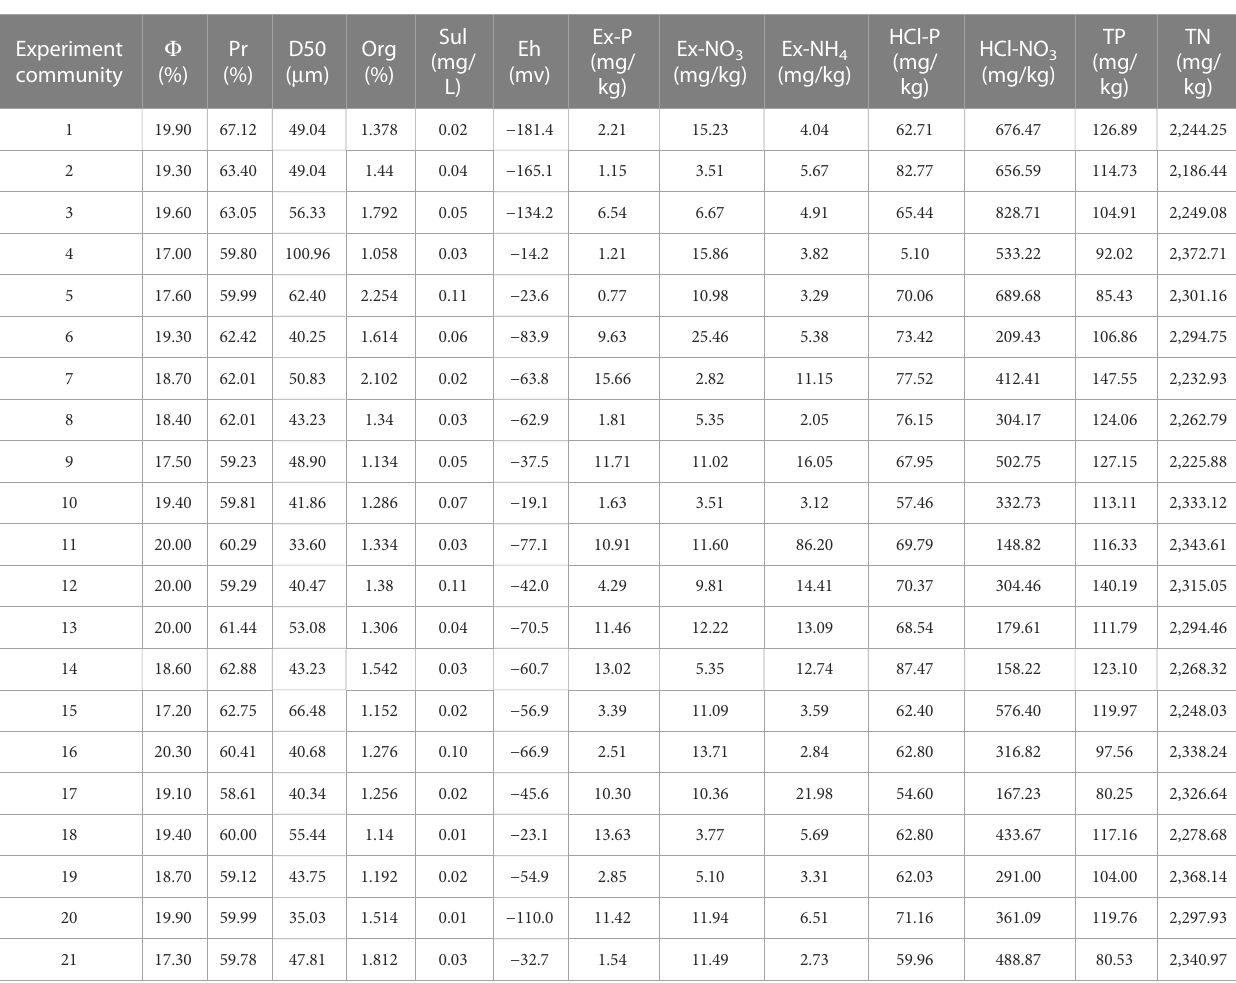
TABLE 2 Sediment factors ( j , Pr, D50, Org, Sul, Eh, Ex-P, Ex-NO 3 , Ex-NH 4 , HCl-P, HCl-NO 3 , TP, and TN represent water content in sediment, porosity, particulate size, organic content in sediment, sul fi de concentration in interstitial water, redox potential of sediment, exchangeable phosphorus content in sediments, exchangeable nitrate nitrogen content in sediments, exchangeable ammonia nitrogen content in sediments, phosphorus content that can be soaked out by hydrochloric acid in sediments, nitrogen content that can be soaked out by hydrochloric acid in sediments, total phosphorus content in sediment, and total nitrogen in sediment,